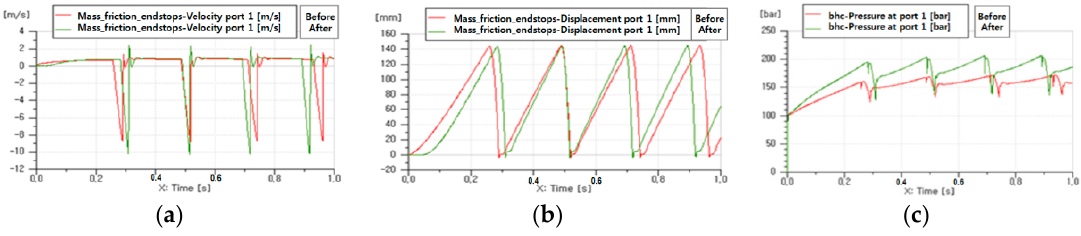
Figure 4. Simplified hydraulic breaker model: ( a ) velocity; ( b ) displacement; ( c ) pressure.